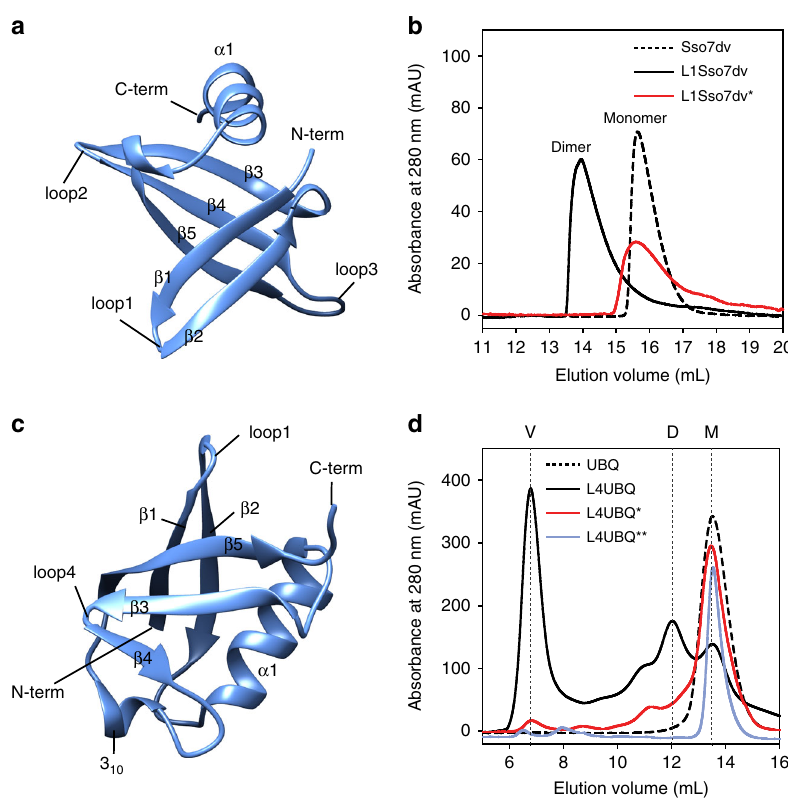
Fig. 6 Domain swapping in Sso7dv and UBQ. a Structure of Sso7d (PDB ID: 1BNZ) is shown. Different secondary structural elements, the N-termini and C-termini, and loop1, loop2, and loop3 of Sso7d are indicated. b Size exclusion pro fi les of Sso7dv, L1Sso7dv, and L1Sso7dv*, at pH 7.5, are shown. L1Sso7dv* is a variant of L1Sso7dv, in which the QVVAG sequence was mutated to QVNAG. Elution volumes corresponding to the monomeric and dimeric species are indicated. c Structure of human ubiquitin (UBQ) (PDB ID: 1UBQ) is shown. Different secondary structural elements, the N-termini and C-termini, and loop1 and loop4 of UBQ are indicated. d Size exclusion pro fi les of UBQ, L4UBQ, L4UBQ* and L4UBQ** at pH 8.3, are shown. L4UBQ* and L4UBQ** are variants of L4UBQ, in which the QVVAG sequence was mutated to QVNAG and QNNAG, respectively. The elution volumes of the monomer (M), dimer (D) and the void fraction (V) are indicated. Source data are provided as a Source Data fi